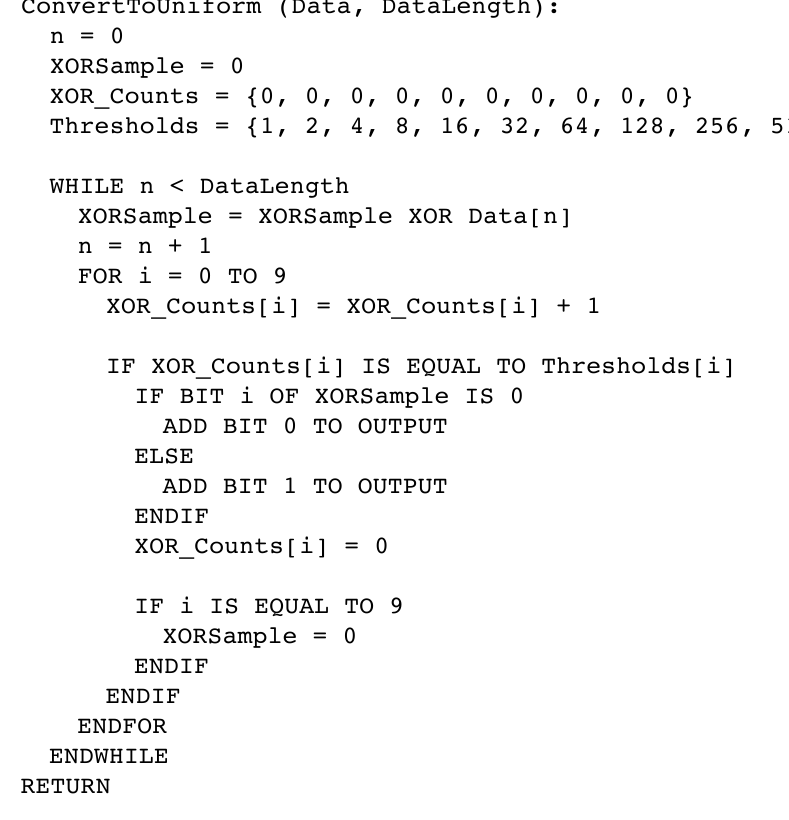
Fig. 9. C pseudo code for conversion